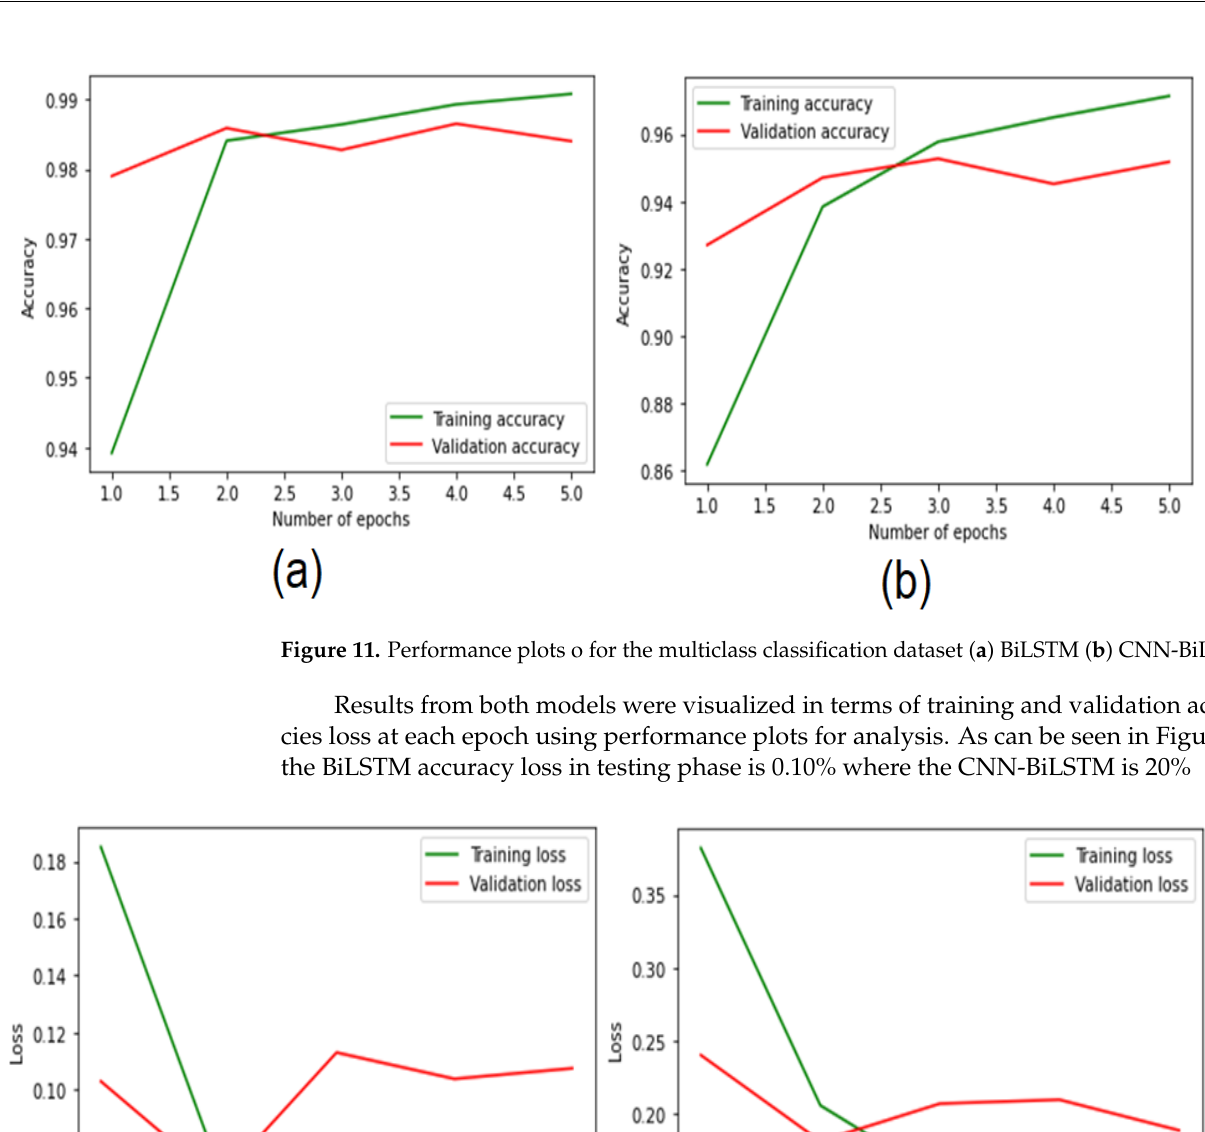
Figure 12. Loss plot for the multiclass classification dataset ( a ) BiLSTM ( b ) CNN-BiLSTM.